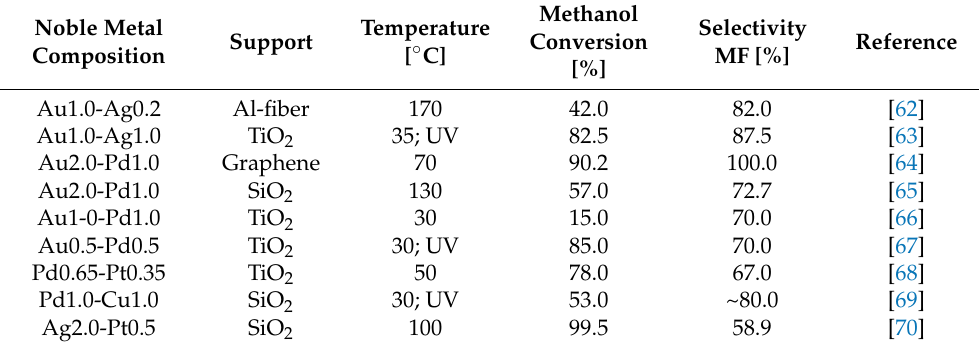
Table 4. Noble metal composite catalysts for the partial oxidation methanol to